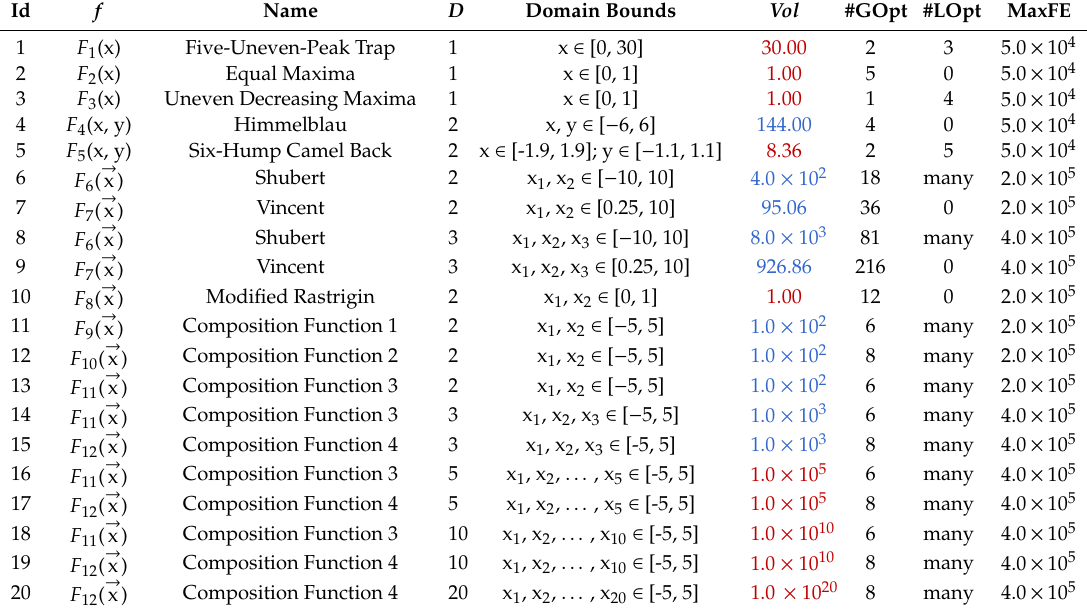
Table 2. Characteristics of the test problems and budget allowance. Each value in red represents a search space volume that is either small or large; if blue, it denotes a volume of a medium